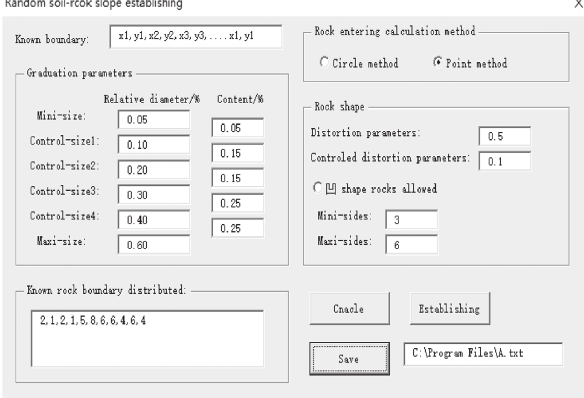
Figure 9: Operation interface of rocks